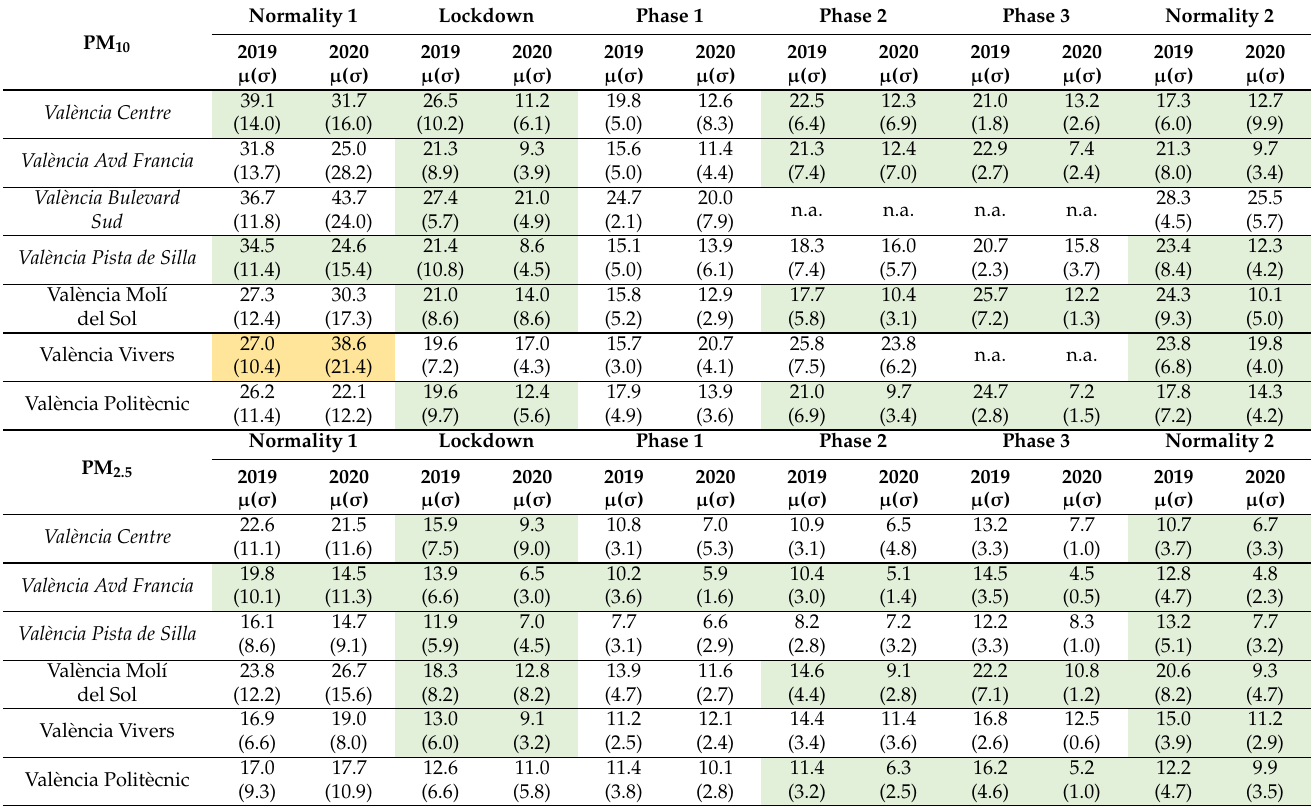
Table 2. PM 10 and PM 2.5 mean and standard deviation ( σ ) are expressed in µ g · m − 3 . A green color denotes a significant ( p -value < 0.05) decrease, whereas an orange color denotes a significant increase between 2019 and 2020. Normality PM 10